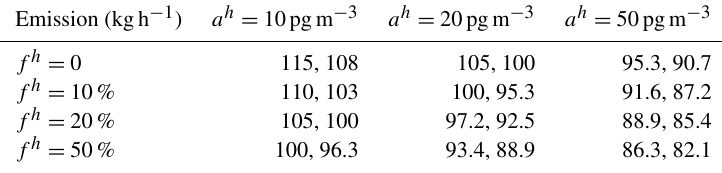
Table 11. Emission strength estimates by using the average and median value of nine simulations for release 2. The cost function is normal- ized F as in Eq. (5). Logarithm concentration is taken as the metric variable. ((cid:15) ln (c) m ) 2 = [ ln ( 1 + f o + a a o = 20pgm − 3